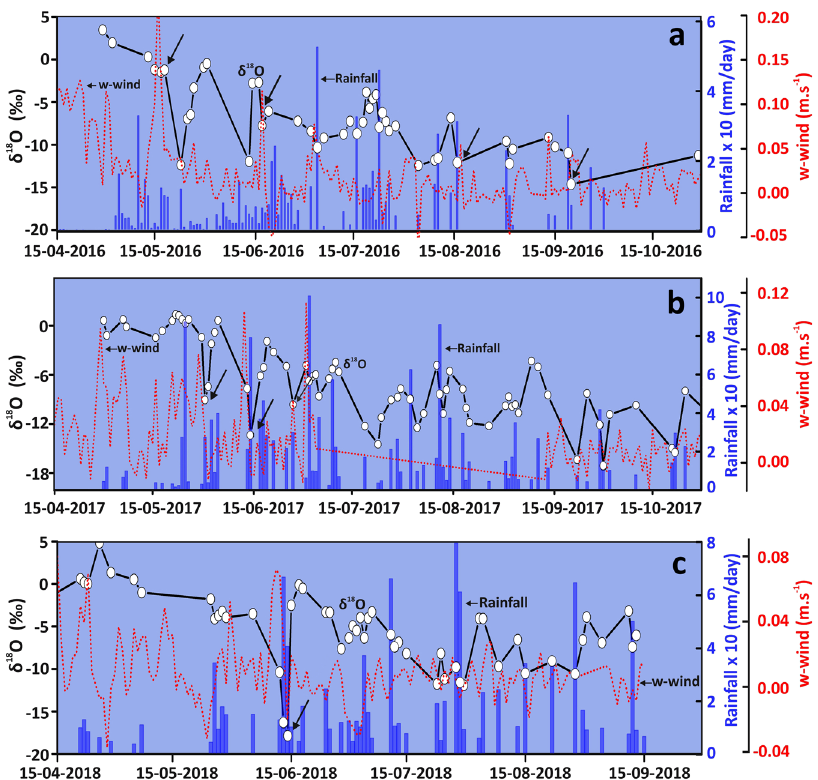
Fig. 4 Co-variability of Tezpur precipitation δ 18 O and the w-wind. The daily time-series plots show the co-variability of δ 18 O and the w-wind parameters for years a 2016, b 2017, and c 2018 for the Tezpur site. The link between the isotopic lows and the vertical wind speed represents the convective processes. The diagonal arrows are marked where low isotopic values are associated with high w-wind. Blue bars show the daily rainfall